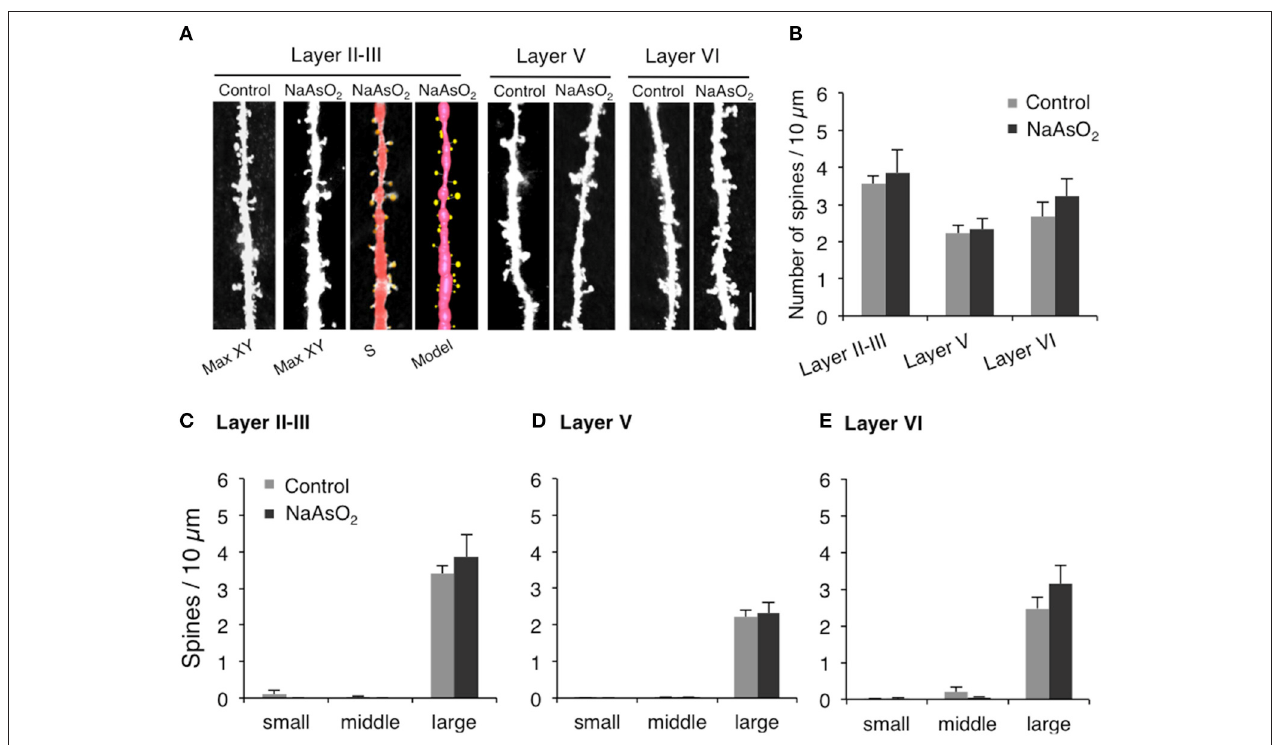
FIGURE 4 | The density and the morphology of dendritic spines in the PrL of adult female mice born from dams exposed to NaAsO 2 during gestation. Dendritic spines were analyzed along the primary basilar dendrites of Golgi-stained pyramidal neurons in three different cortical layers (layer II − III, V, and VI) of PrL. (A) Representative photomicrographs of dendritic spines with maximal intensity projections onto the XY plane from Z-series images (Max-XY) for the control group (Control) and NaAsO 2 -exposed group. Photomicrographs analyzed by Spiso-3D (S) and three-dimensional models (Model) are also shown for the analysis of dendritic spines in the layer II − III of the NaAsO 2 -exposed group. (B) Effect of NaAsO 2 exposure on the total dendritic spine density of pyramidal neurons in three different cortical layers. Effect of NaAsO 2 exposure on the density of three subtypes of dendritic spines, small-head spines (small), middle-head spines (middle), and large-head spines (large), in three cortical layers of the PrL: Layer II − III (C) , Layer V (D) , and Layer VI (E) . The density of dendritic spines is expressed as the number of spines per 10 µ m of dendrite. A total 500 − 1200 spines from 30 to 45 dendritic segments of 30 − 45 neurons were analyzed for each cortical layer. Values are expressed as mean ± SEM (control group n = 7, NaAsO 2 -exposedgroup n =